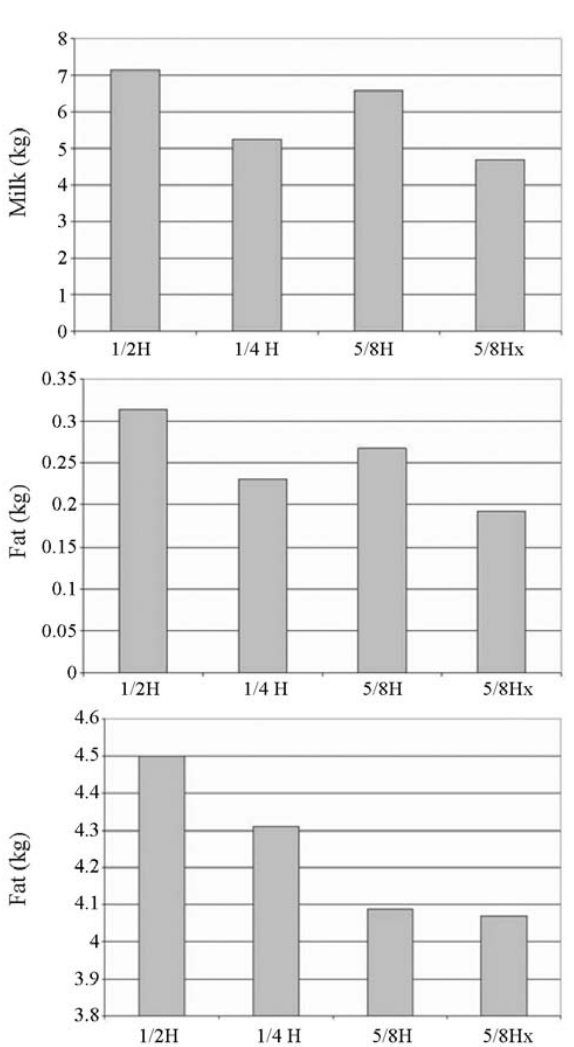
Figure3 -Effectsofgeneticgroupsonmilkyield(MY),fatyield(FY)and fat percentage (FP) of crossbred Holstein-Zebu